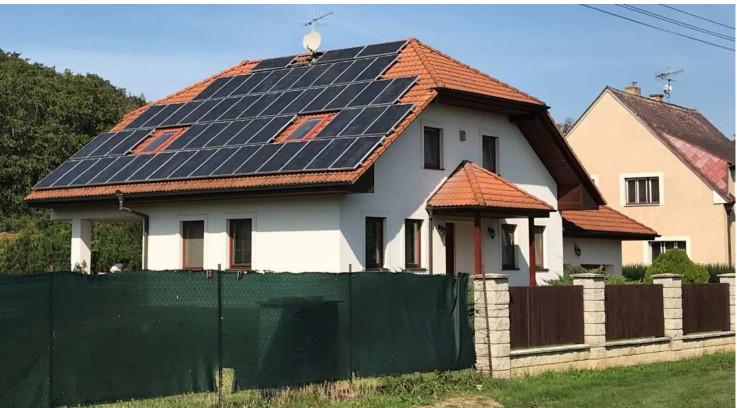
Figure 3. Example of a residential dwelling with solar panels in rural Czechia. Source: own